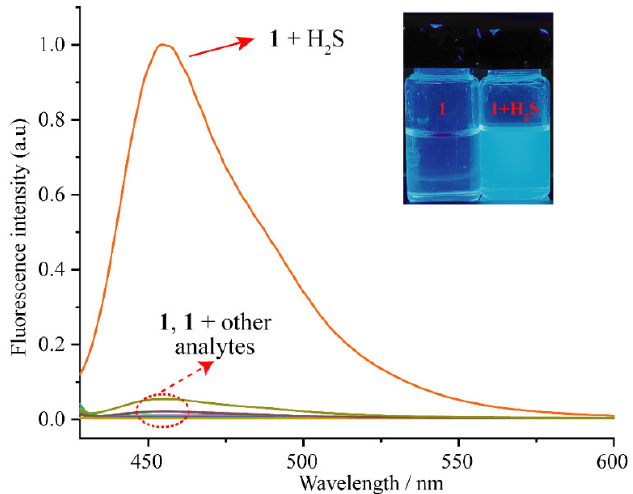
Figure 2. Fluorescence emission spectra of 1 (10 μM) treated with various analytes (10 equiv.) in H 2 O-CH 3 CN (1:1, v/v , 10 mM PBS, pH = 7.40) mixed aqueous medium (λ ex = 413 nm, slit = 10 nm/10 nm). The inset was the corresponding color change of 1 following the addition of H 2 S under UV light (365 nm).